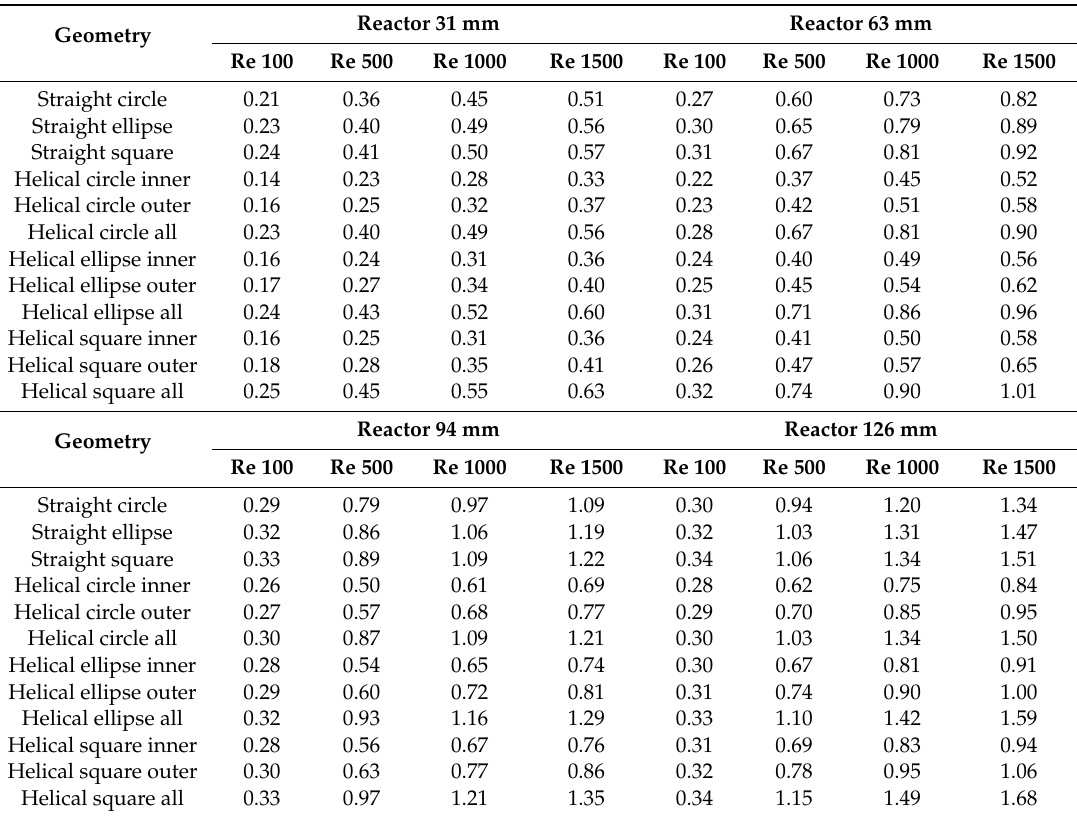
Table 5. Power generation from methane combustion in single channel ventilation air methane (VAM) reactor (Watt).